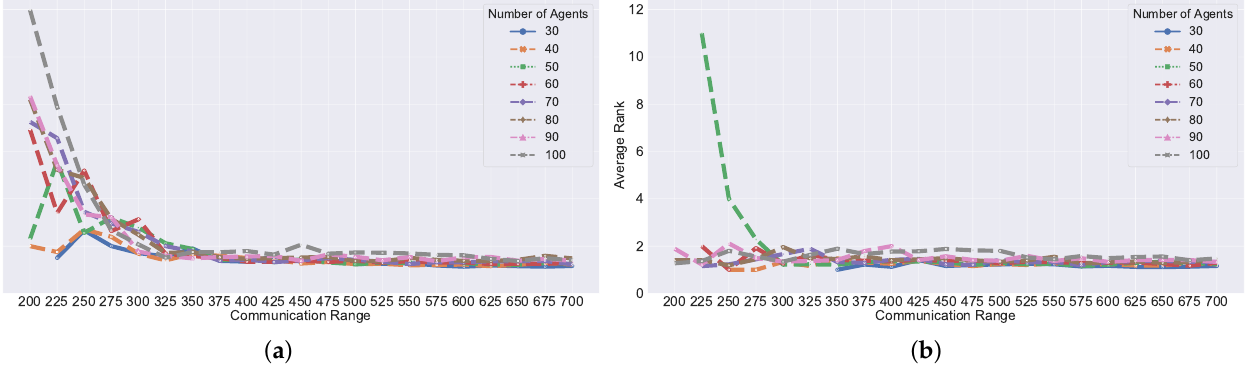
Figure 15. The average rank with 15-vote threshold. ( a ) Our proposed method with respect to different swarm size. ( b ) The Raft-based method with respect to different swarm